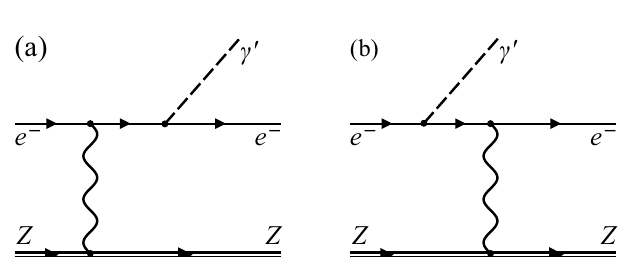
Figure 1. Radiative production of a dark photon via Bremsstrahlung of a heavy target